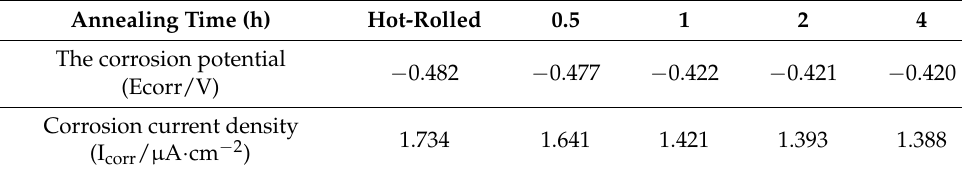
Figure 13. Polarization curves of TA10 alloy. Table 2. Corrosion potential and corrosion current density of TA10 alloy.